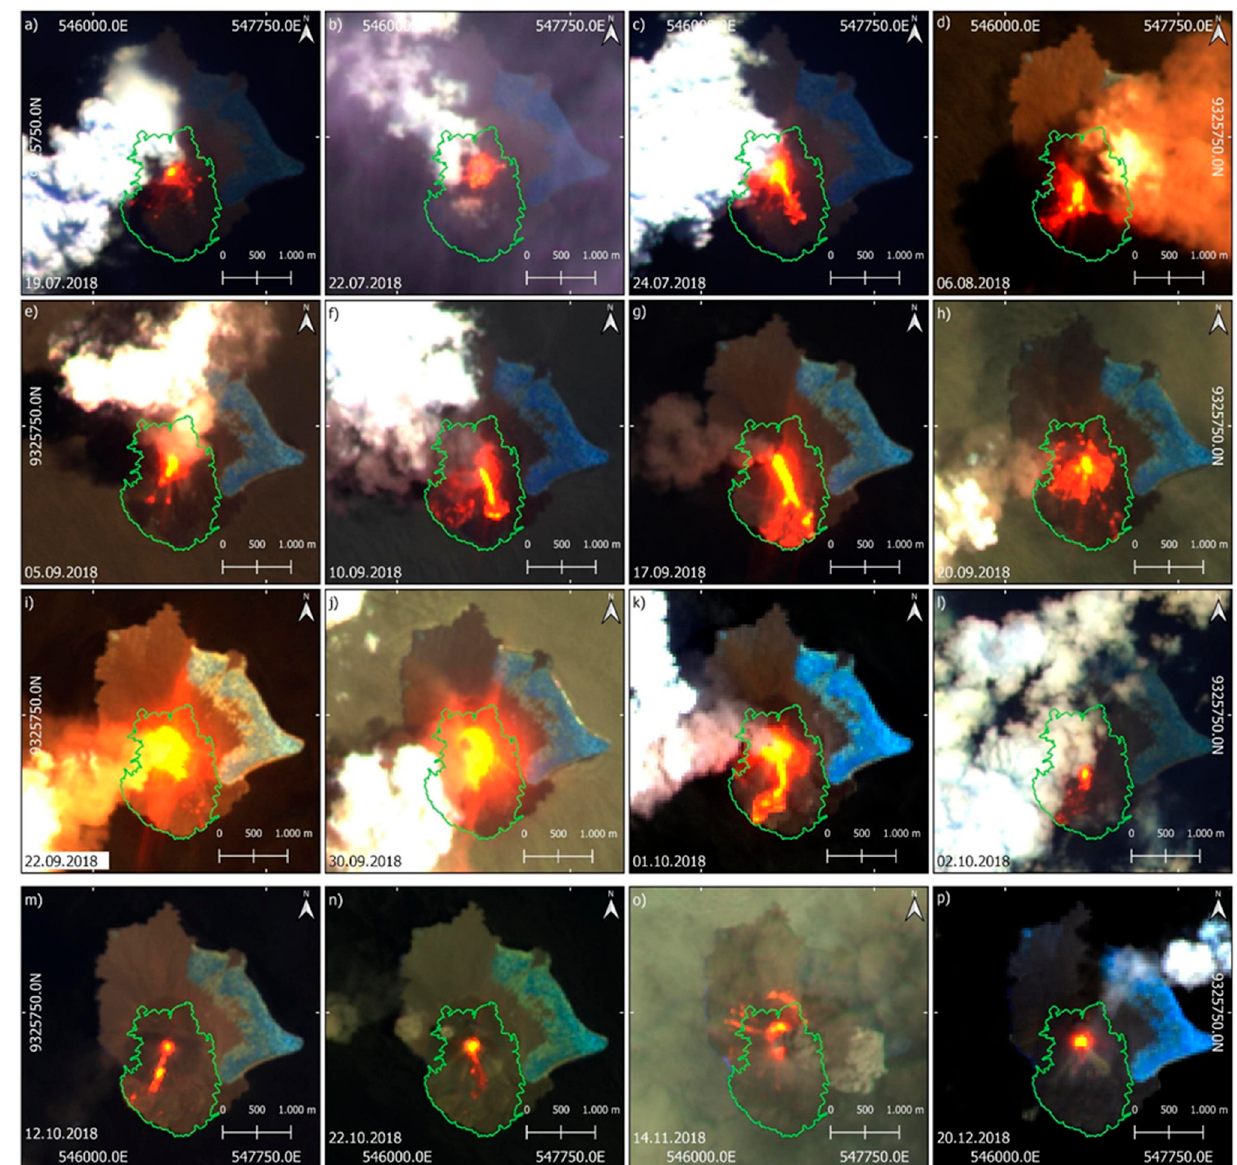
towards the W flank. Thermal anomalies of the lava flow are displayed in red to yellow, with yel- lower pixel indicating higher temperatures.